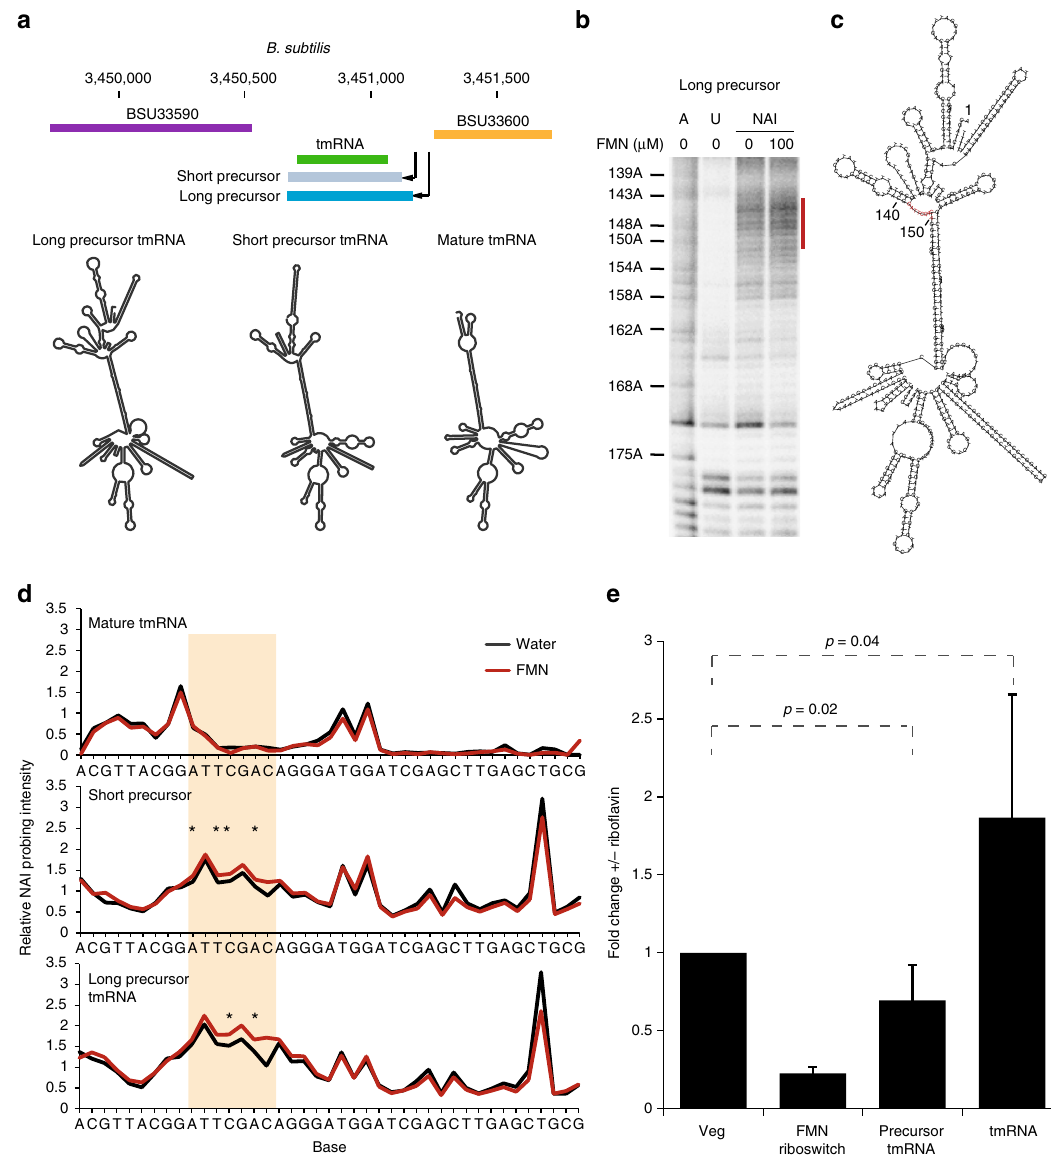
Fig. 3 Precursor tmRNA can act as an RNA sensor for FMN. a Schematic of the B . subtilis tmRNA genomic locus (top) and predicted secondary structures of the long precursor tmRNA, short precursor tmRNA, and mature tmRNA, using the RNAfold program 20 (bottom). b RNA footprinting analysis of the long precursor tmRNA, using a SHAPE-like chemical (NAI), in the presence (lane 4) and absence (lane 3) of 100 µ M FMN. Also shown are A ladder (lane 1) and unmodi fi ed RNA (lane 2). The red bar indicates bases that become more single-stranded in the presence of FMN. c Predicted secondary structure of the tmRNA long precursor using the RNAfold program 20 . The red bases correspond to the positions marked by the red bar in b . d Average footprinting analysis ( n = 3, SAFA) of mature (top), short precursor (middle), and long precursor tmRNA (bottom), in the presence (red) and absence (black) of 100 µ M FMN, in the dark. The beige box indicate the region of increased fl exibility in the precursor tmRNAs in the presence of FMN. The stars indicate bases that show statistically signi fi cant changes with FMN ( p ≤ 0.05, Student t -test). e qPCR analysis of the mRNA expression level of precursor tmRNA and mature tmRNA, across six biological replicates, after addition of 100 µ M of ribo fl avin to the growth media of B . subtilis . Fold changes are normalized to the negative control Veg gene. The known B . subtilis FMN riboswitch is used as the positive control. p -values were calculated by Student ’ s t -test, the error bars indicate standard deviation of the